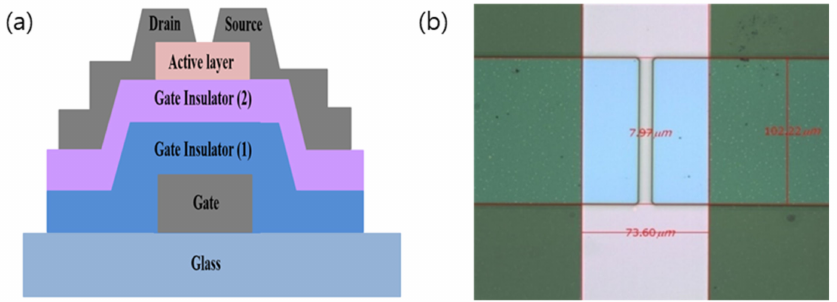
Figure 1. ( a ) Schematic structure of a-IGZO TFT with a dual-layer gate insulator. ( b ) Top view of the channel using an optical